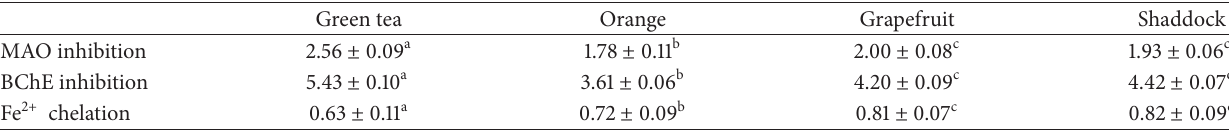
Table 2: EC values of inhibition of monoamine oxidase, butyrylcholinesterase, and Fe 2+ chelating abilities of green tea and some citrus 50 peels’